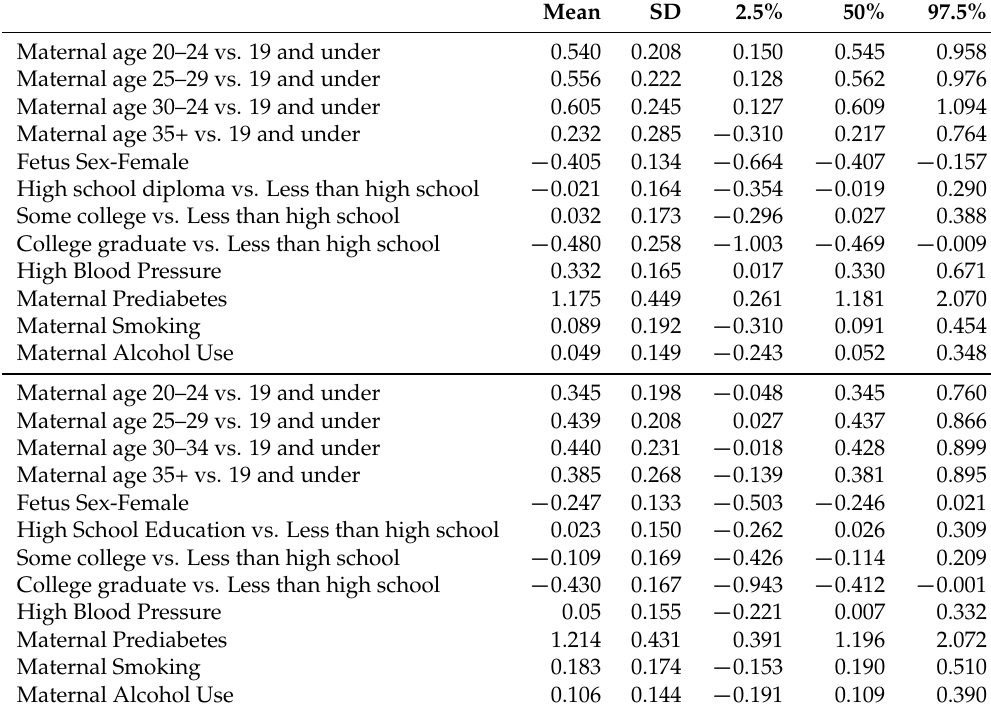
Table 3. The posterior means, standard deviation (SD), and quantiles for a change in cleft lip defects (top) and cleft palate defects (bottom) in the National Birth Defects Prevention Study,